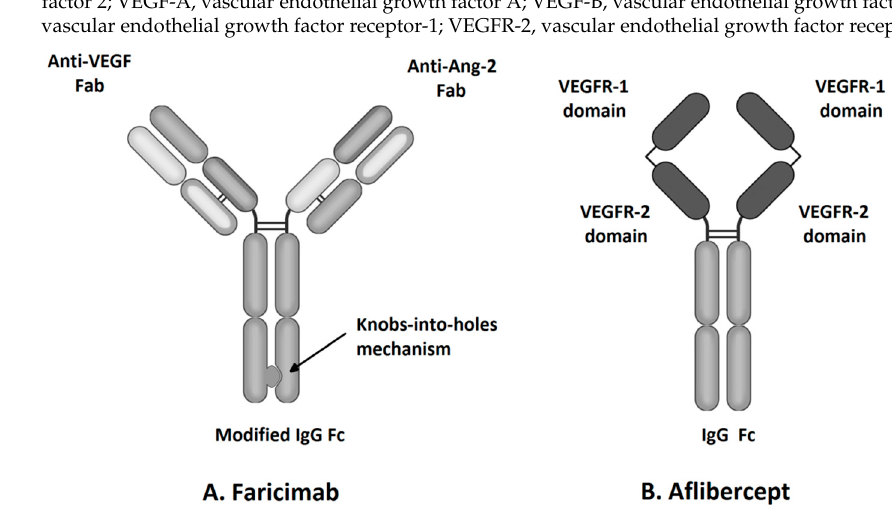
Figure 1. Molecular structure of faricimab and aflibercept.